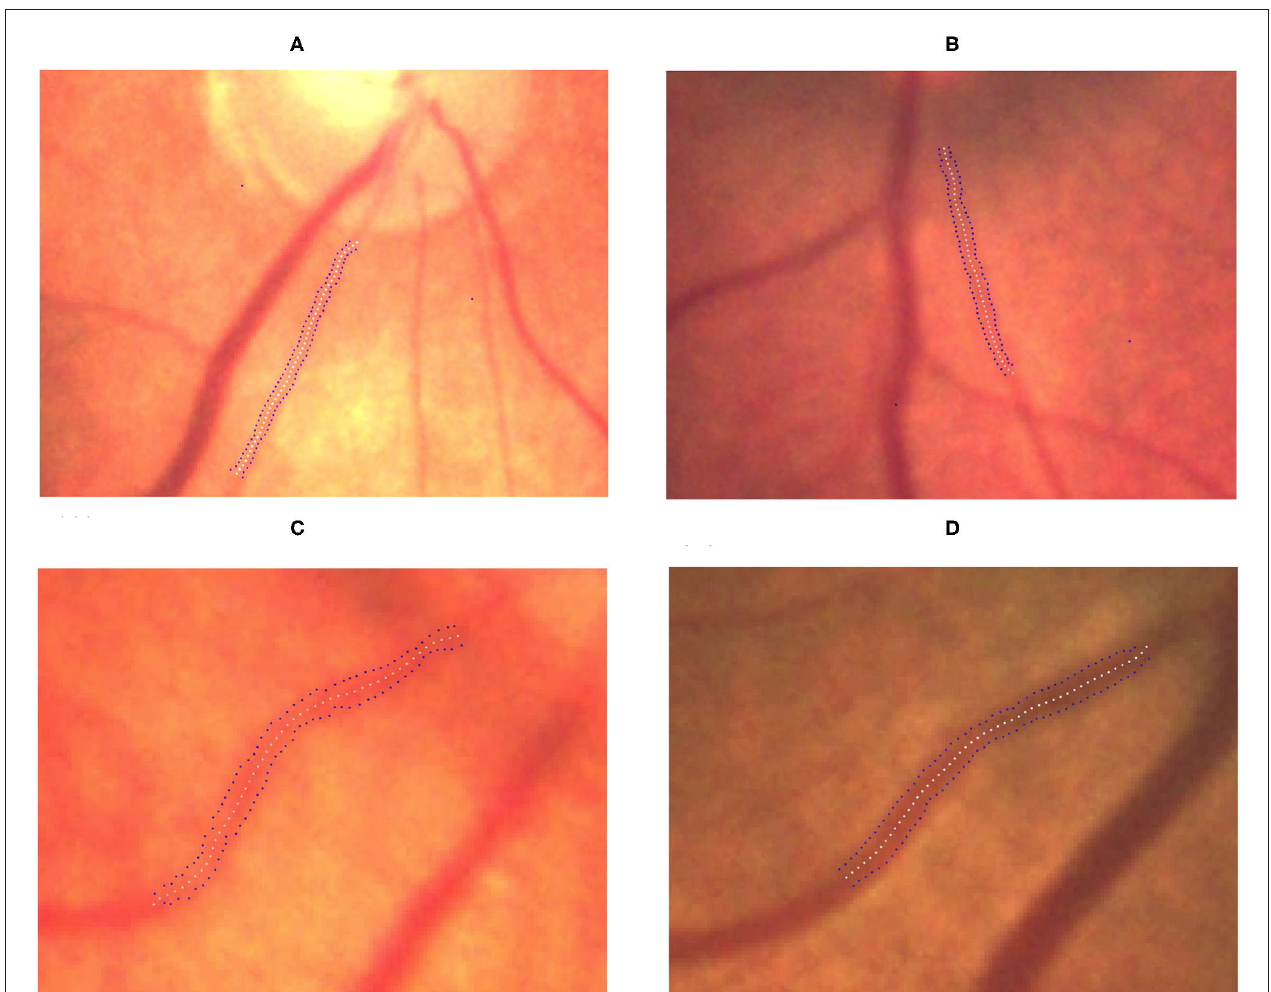
FIGURE 4 | Gradual increment in TAW from no ROP to stage 3 ROP. (A) No-ROP, (B) stage 1 ROP, (C) stage 2 ROP, and (D) stage 3 ROP groups, with widths 4.15, 4.92, 5.14, and 6.28 pixels, respectively. The white dotted curve indicates the centerline of the vessel, and the blue dotted curves indicate the borderlines of the